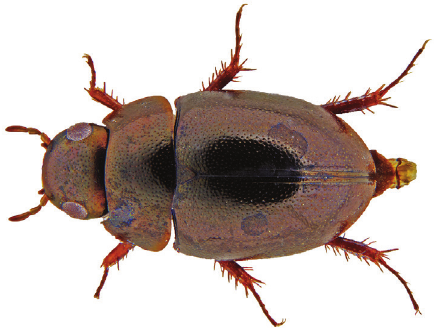
Figure 19. Paracymus amplus Wooldridge, 1977 2.5 mm, iSimangaliso Wetland Park, Catalina Bay (site 32), February 2015 DT Bilton, MS Bird & R Perissinotto leg.